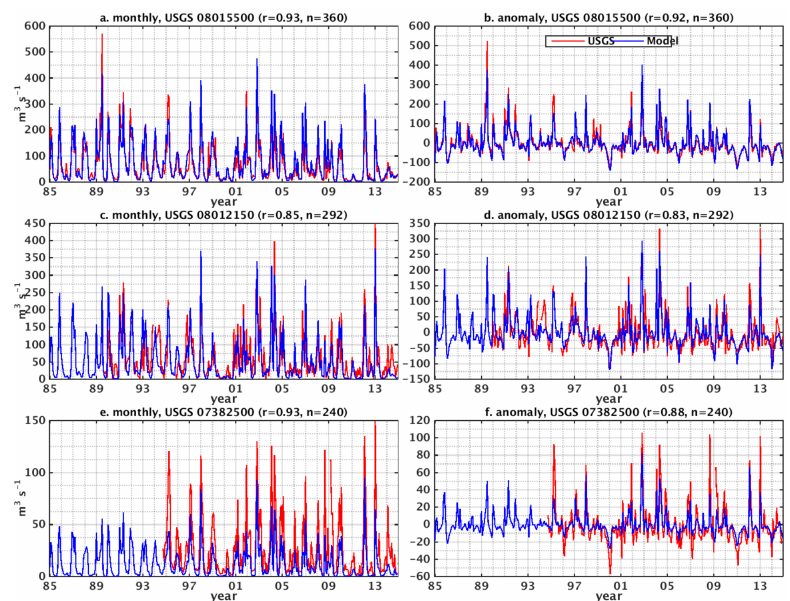
Figure 6. Monthly time series and anomaly of model simulated (blue) and observed (red) streamflow at ( a , b ) Calcasieu River near Kinder, LA (USGS 08015500), ( c , d ) Mermentau River at Mermentau, LA (USGS 08012150), and ( e , f ), Bayou Courtableau of the Vermilion-Teche basin at Washington, LA (USGS 07382500) from 1985 to 2014.